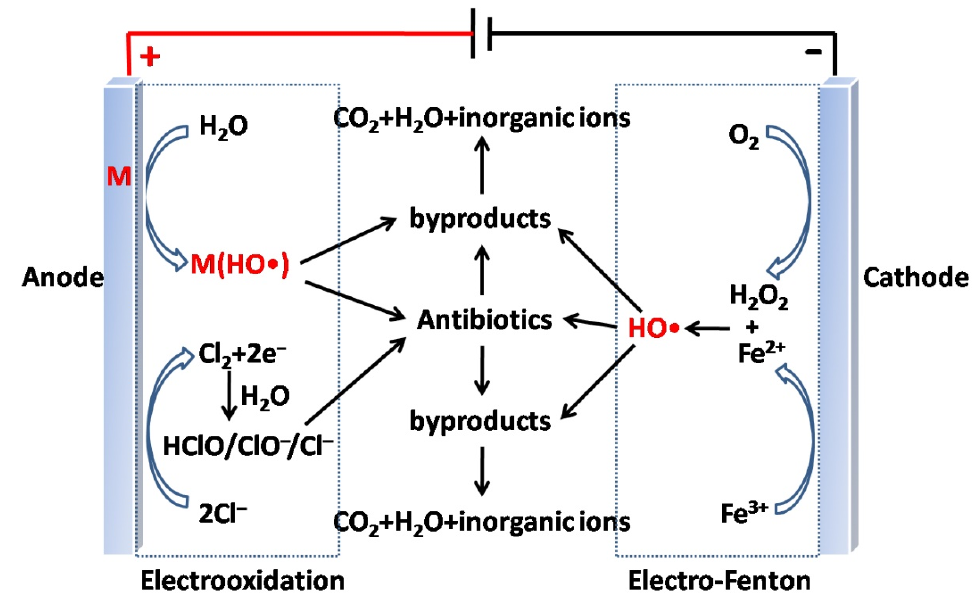
Figure 12. Schematic representation of the mechanism of oxidant production in electrooxidation and electro-Fenton processes (M = Fe, Mn, Ni, Co, Nb, Ti, Zn). Reproduced with permission from